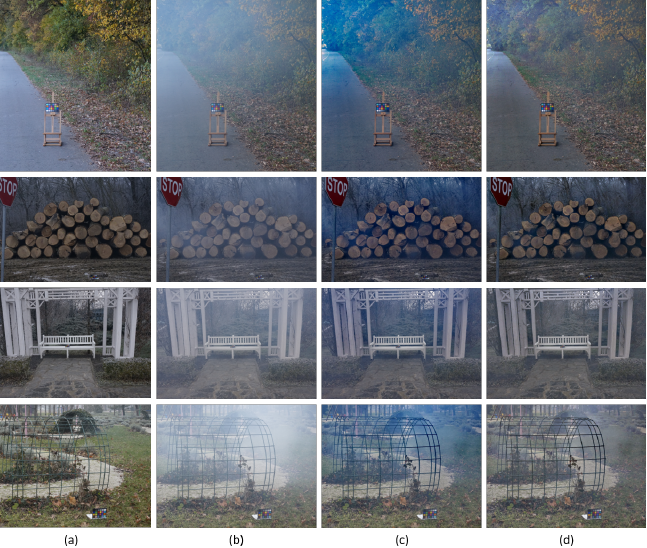
Figure 15. O-HAZE images [40]: ( a ) without fog, ( b ) with fog, ( c ) images restored with the White fog version of our algorithm (W), ( d ) images restored with the color version of our algorithm